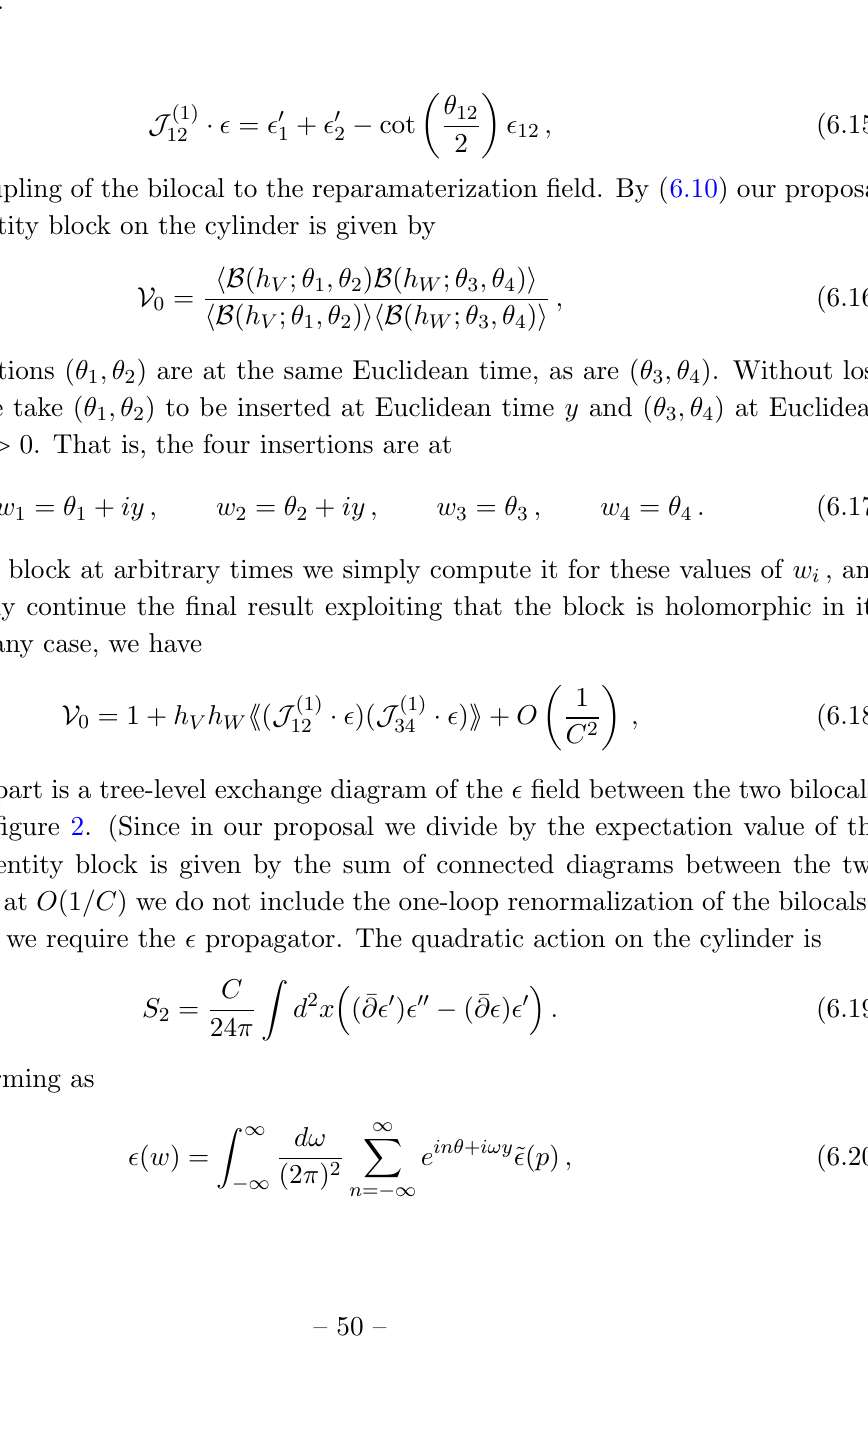
and J (1) are the linear couplings 12 34